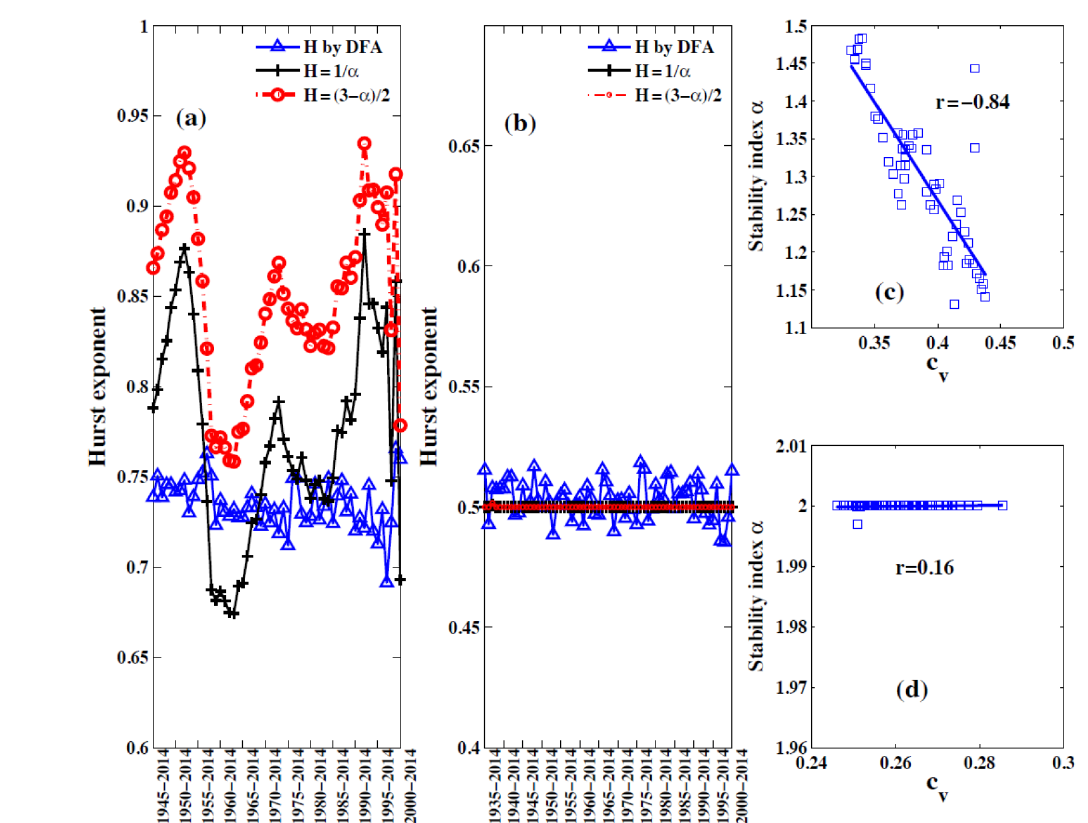
Figure 14. (a) Well 1 groundwater levels: comparison between the Hurst exponent estimated by DFA and by stability index. (b) Well 2 groundwater levels: comparison between the Hurst exponent estimated by DFA and by stability index. (c) Well 1 groundwater levels: the coefficient of variation c v vs. the stability index obtained in panel (a) . (d) Well 2 groundwater levels: the coefficient of variation c v vs. the stability index obtained in panel (b)